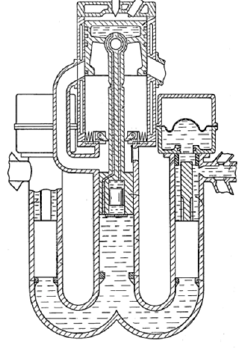
Figure 2. An HFPE [7].